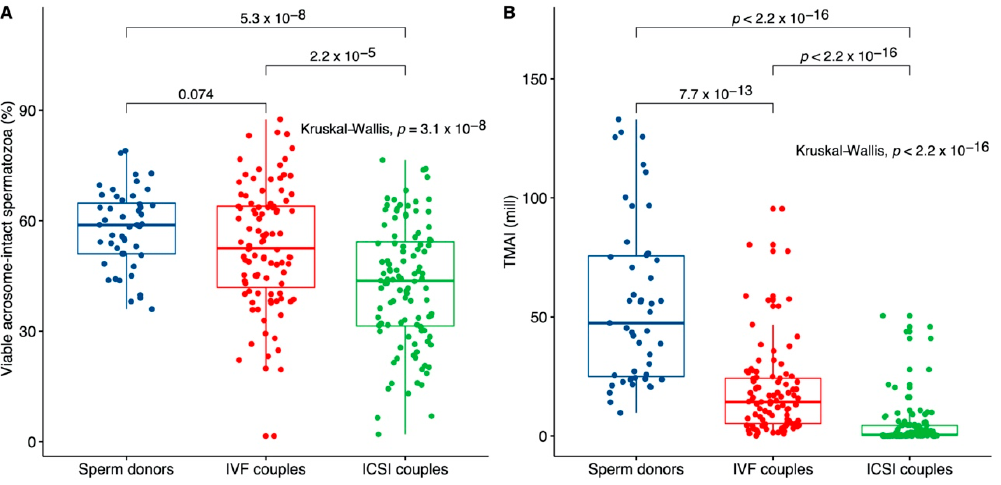
Figure1. Acrosomalstatusofspermdonorsandcouplesinin Figure 1. Acrosomal status of sperm donors and couples in in vitro fertilization (IVF) or intracytoplasmic sperm injection (ICSI) treatment. ( A ) Percentage of viable acrosome-intact spermatozoa in fresh purified semen samples, and ( B ) total number of progressive motile spermatozoa with intact acrosomes (TMAI) in fresh purified semen samples (sperm donors (blue): n = 48; IVF (red): n = 99; ICSI (green): n = 107). The boxplots depict the median and interquartile ranges, and the whiskers mark 1.5x the interquartile range.